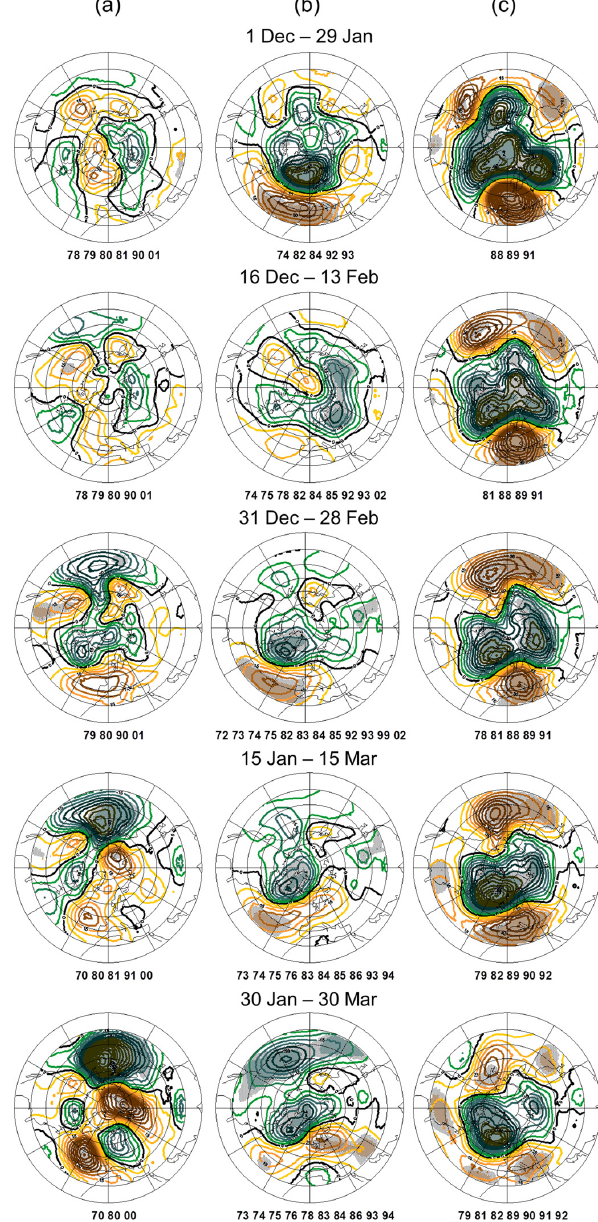
Fig. 4. Troposphere in the years 1970–2002. As in Fig. 3, but for geopotential level 850hPa. The contour interval is